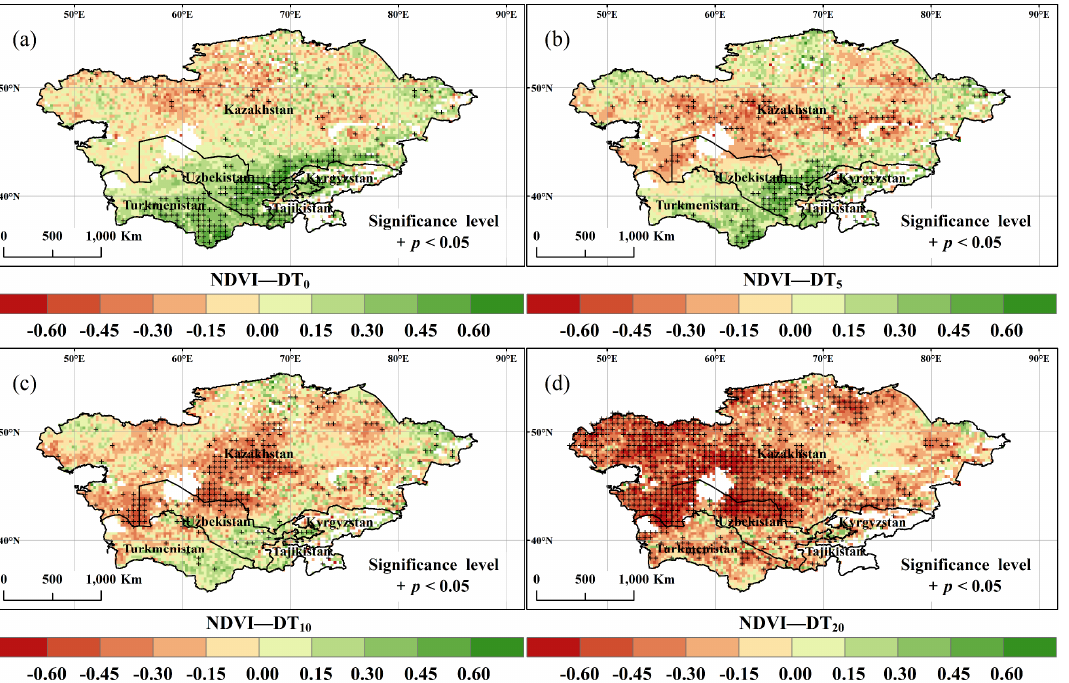
Figure 8. Spatial distribution of correlations between annual NDVI and ( a ) DT 0 , ( b ) DT 5 , ( c ) DT 10 , and ( d ) DT 20 for the period 1982–2014.